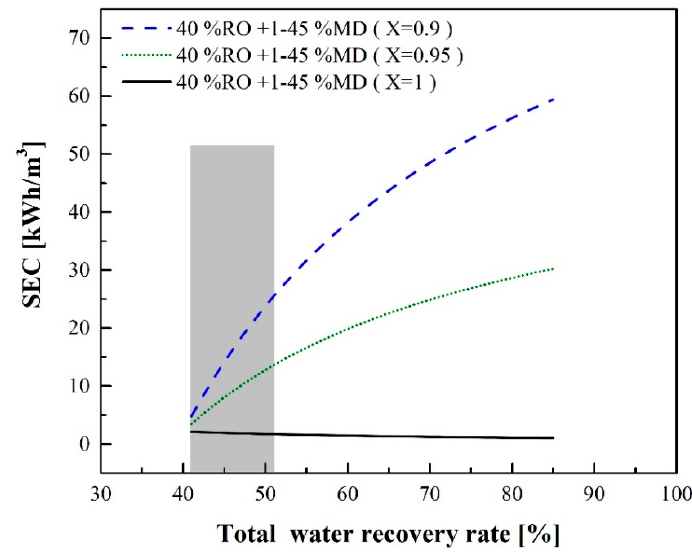
Figure 10. SEC of the RO-MD process with or without a sufficient waste heat source for